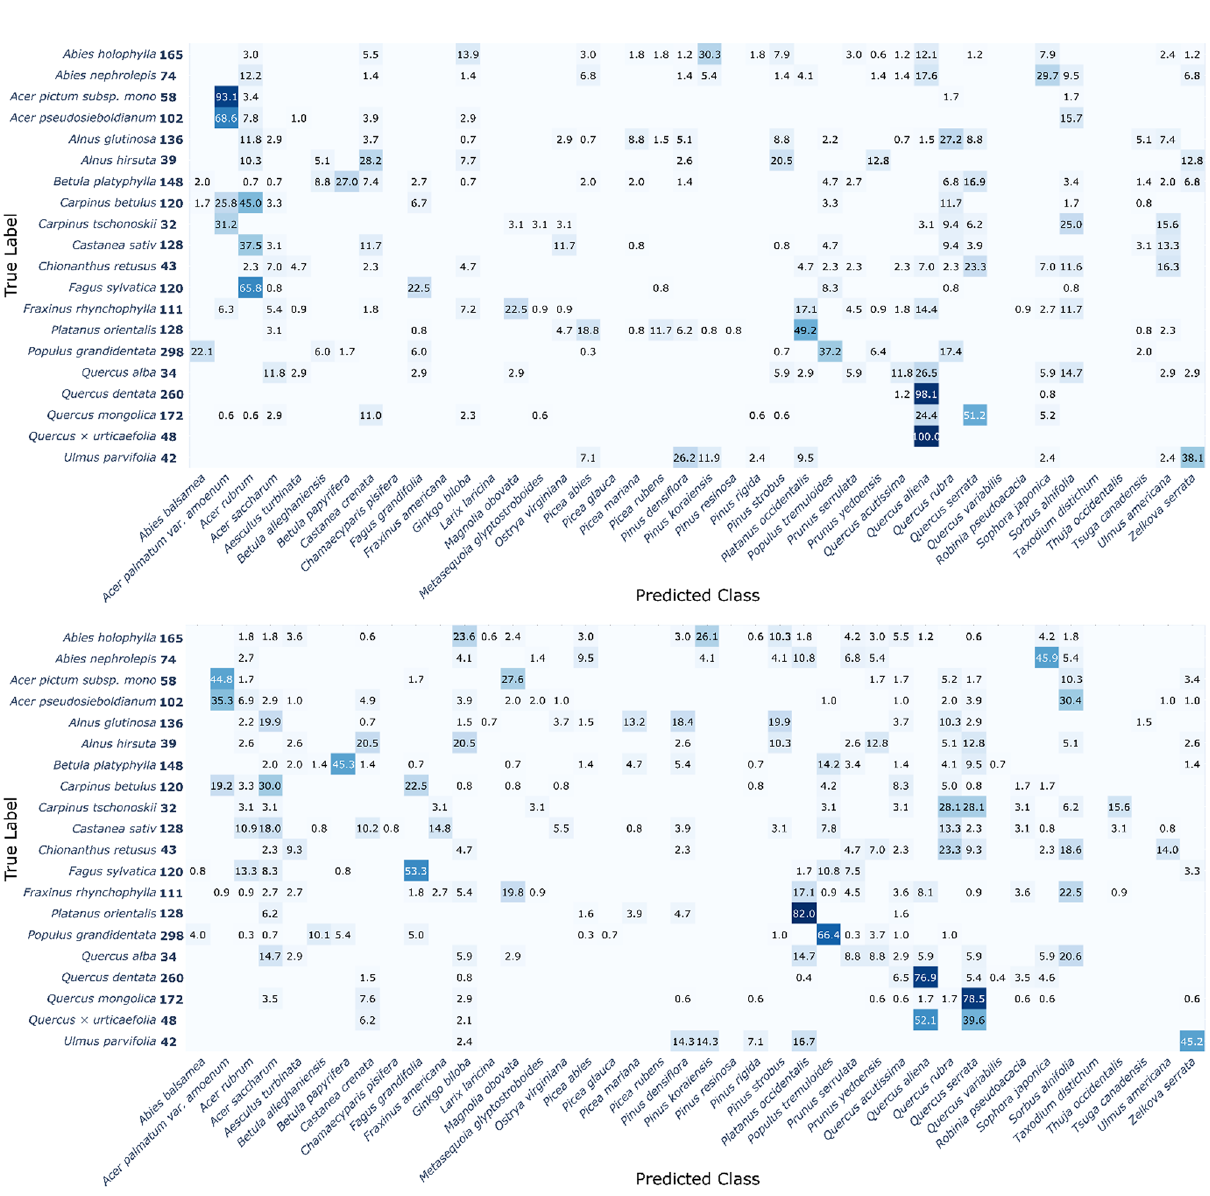
class. The X-axis denotes the prediction class from the original dataset (42 species), and Y-axis indicates the true label from the additional untrained dataset (20 species). The numbers in the Y-axis labels indicate the number of tested samples of each species. Detailed values for the figure are given in Supplementary data